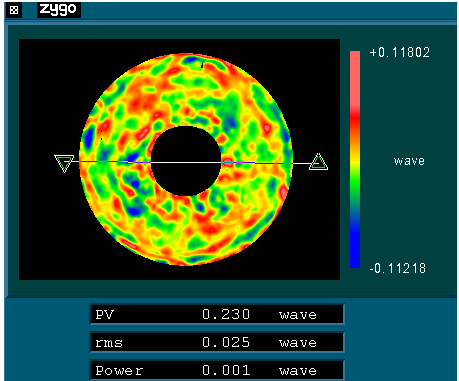
Figure 12. Interferometry test result of the primary mirror.